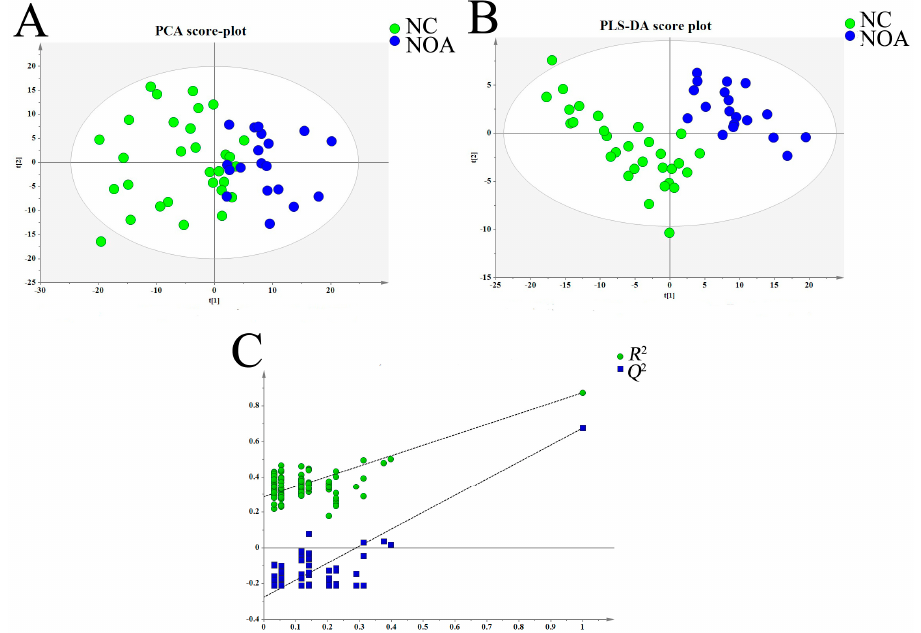
Figure 2. Multivariate statistical analysis of serum metabolic profiling in patients with non-obstructive azoospermia (NOA) and normal controls (NC). ( A ) principal component analysis (PCA) score plot; ( B ) partial least squares-discriminant analysis (PLS-DA) score plot; ( C ) statistical validation of established PLS-DA model with permutation analysis (100 random permutations).